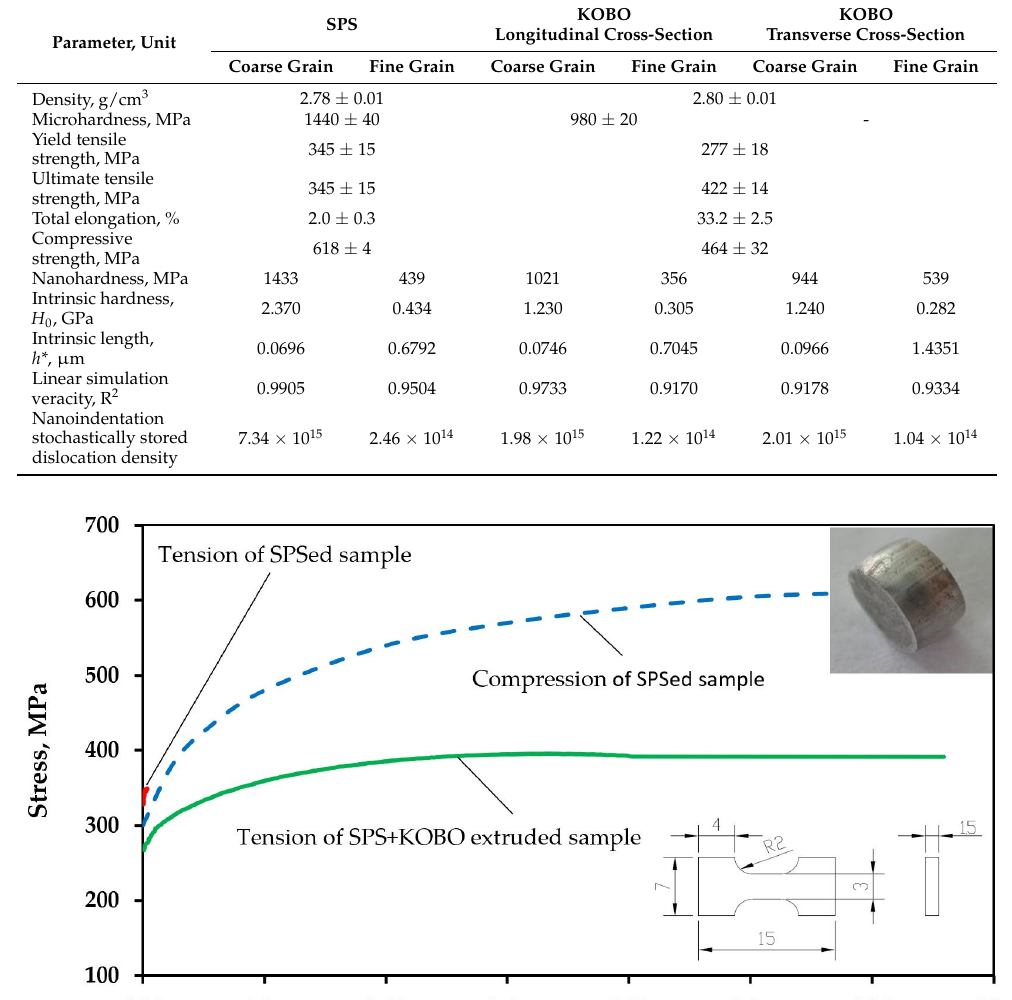
Table 4. Bulk density, mechanical properties, nanohardness, and indentation size effect parameters of coarse and fine grains of SPSed and SPS-KOBO extrudedAA7075.